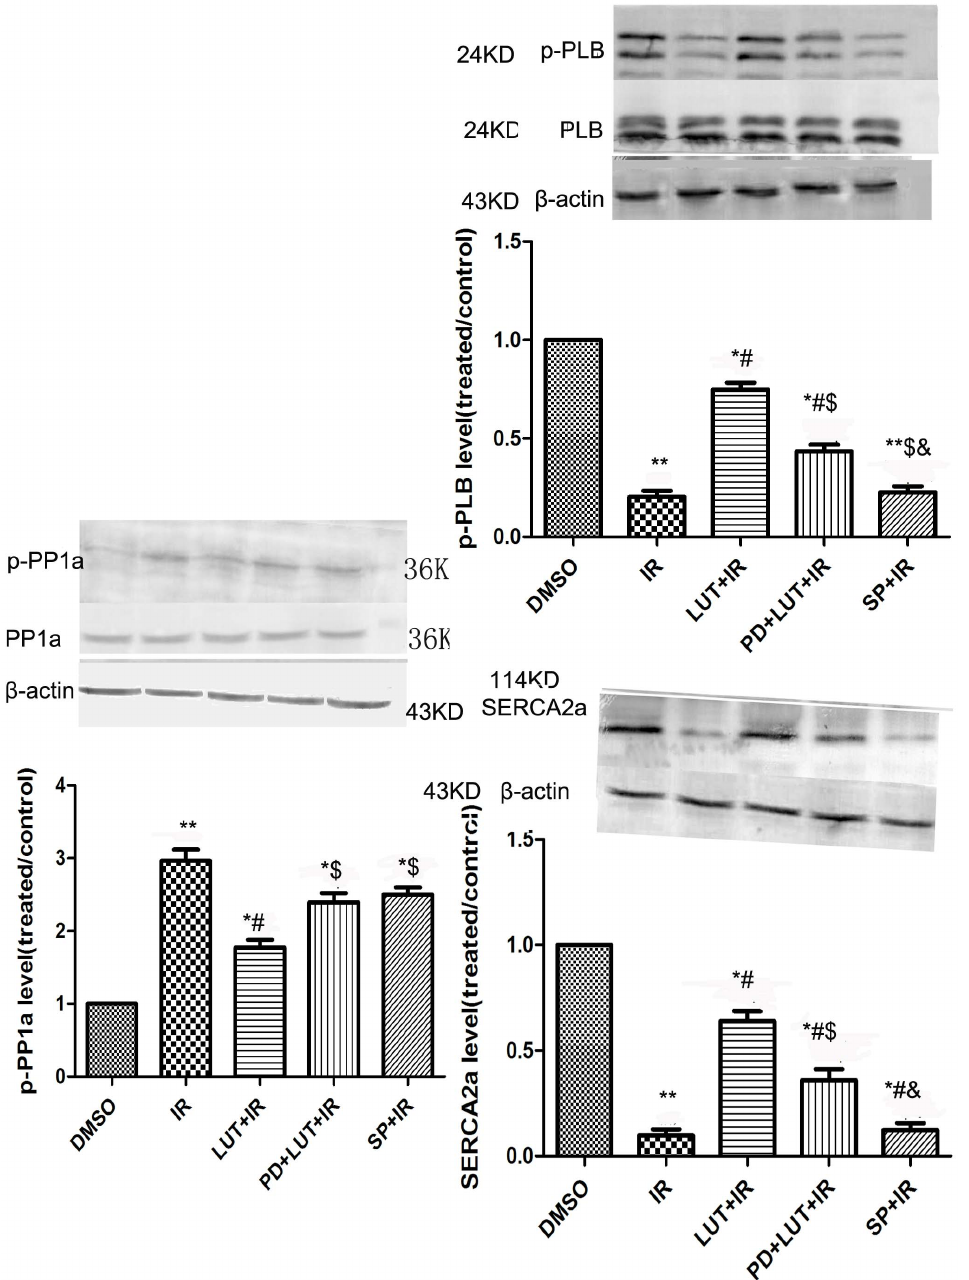
Figure 6. The expression of p-PP1a, p-PLB and SERCA2a. The effects of luteolin and SP600125 on the expression of total PP1a and phospho- PP1a (A, B), total PLB and phospho-PLB (C, D), SERCA (E, F). The results were expressed as the mean 6 SEM, n=3. * P , 0.05, ** P , 0.01 versus DMSO; # P , 0.05 versus I/R; $ P , 0.05 versus I/R + Lut (8.0 m M); & P , 0.05 versus I/R + Lut(8.0 m M) + PD(10 m M).